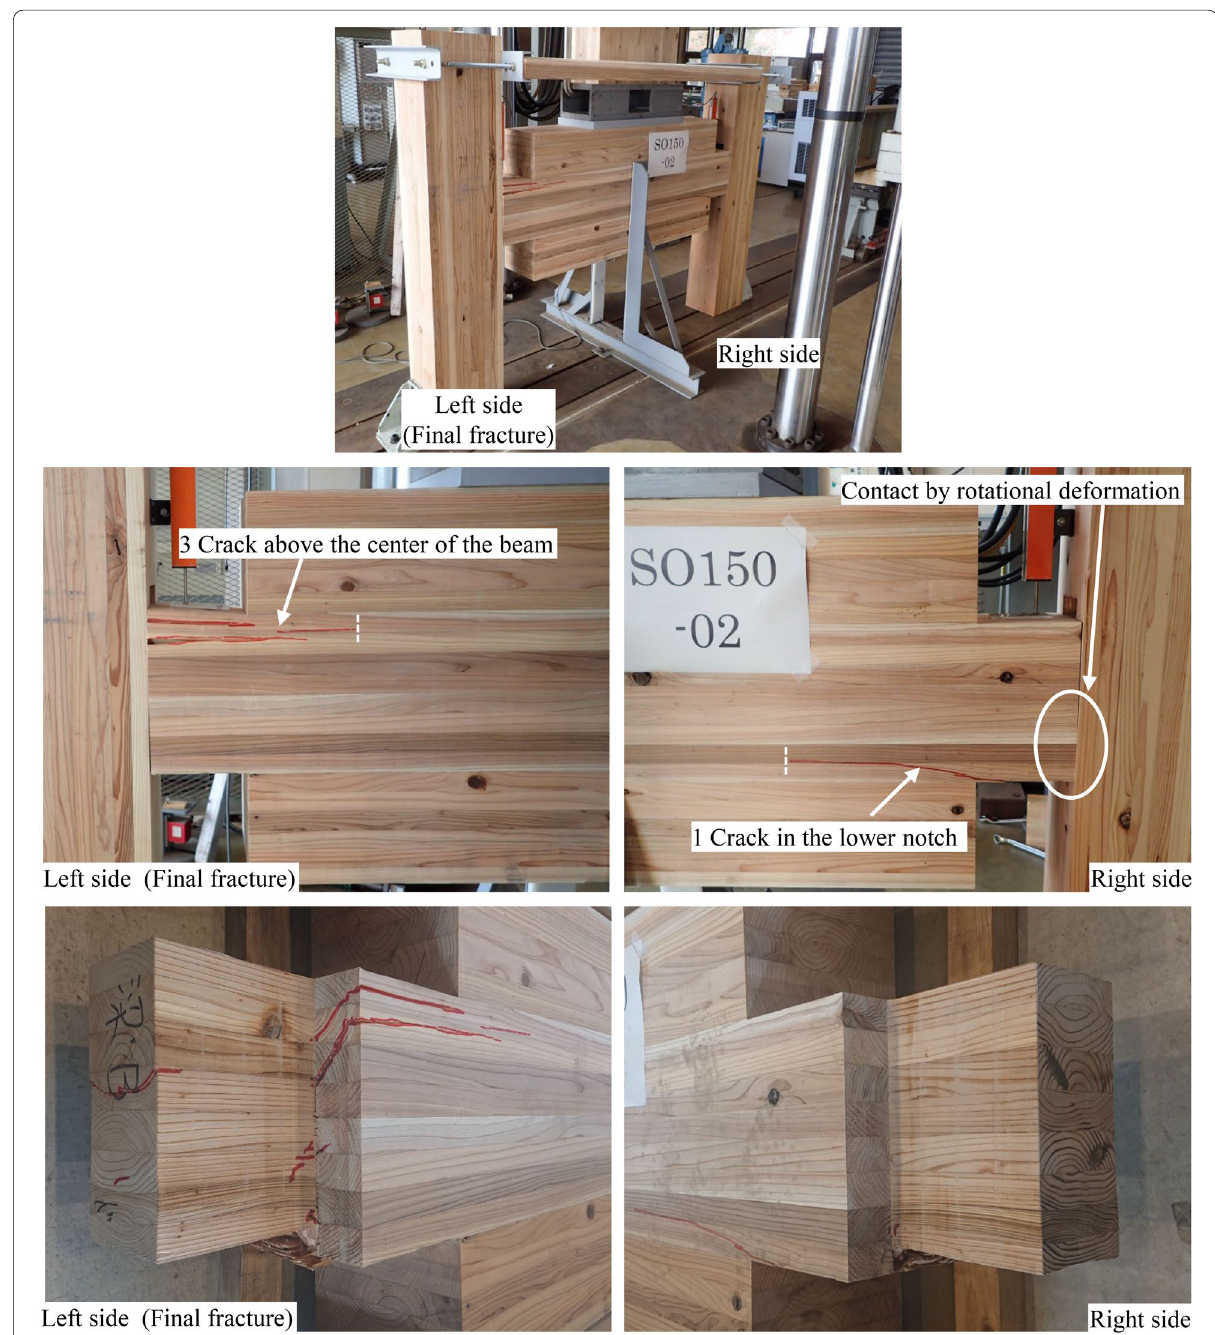
Fig. 14 Final fracture state of the specimen (J-L150, No.